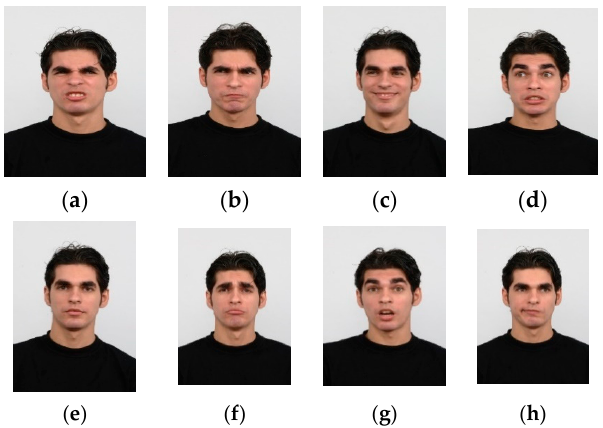
Figure 2. Sample images taken from Radboud faces database (RaFD) dataset displaying various emotions ( a ) anger, ( b ) disgust, ( c ) happy, ( d ) fear, ( e ) neutral, ( f ) sad, ( g ) surprise and ( h )